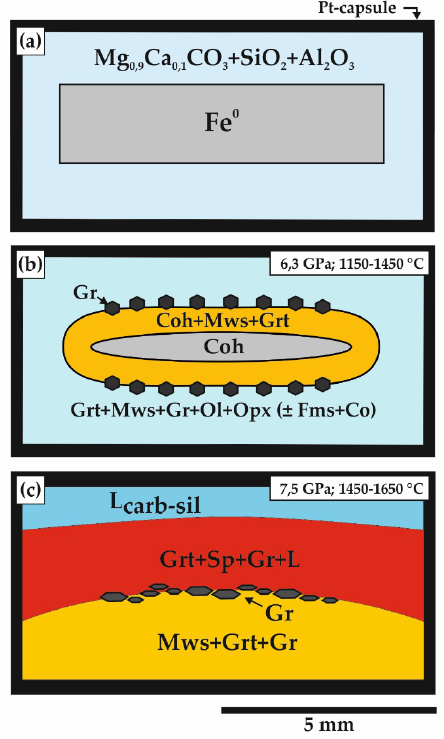
Figure 6. A scheme of an initial ampoule assembly ( a ) and schemes of ampoules after experiments on carbonate-oxide-metal interaction at 6.3 GPa and 1150–1450 °C ( b ) and 7.5 GPa and 1450–1650 °C ( c ); Coh: cohenite, Mws: magnesiowustite, Grt: garnet, Ol: olivine, Gr: graphite, Fms: ferromagnesite, Opx: orthopyroxene, Co: coesite, Sp: spinel, L carb-sil : carbonate-silicate melt.